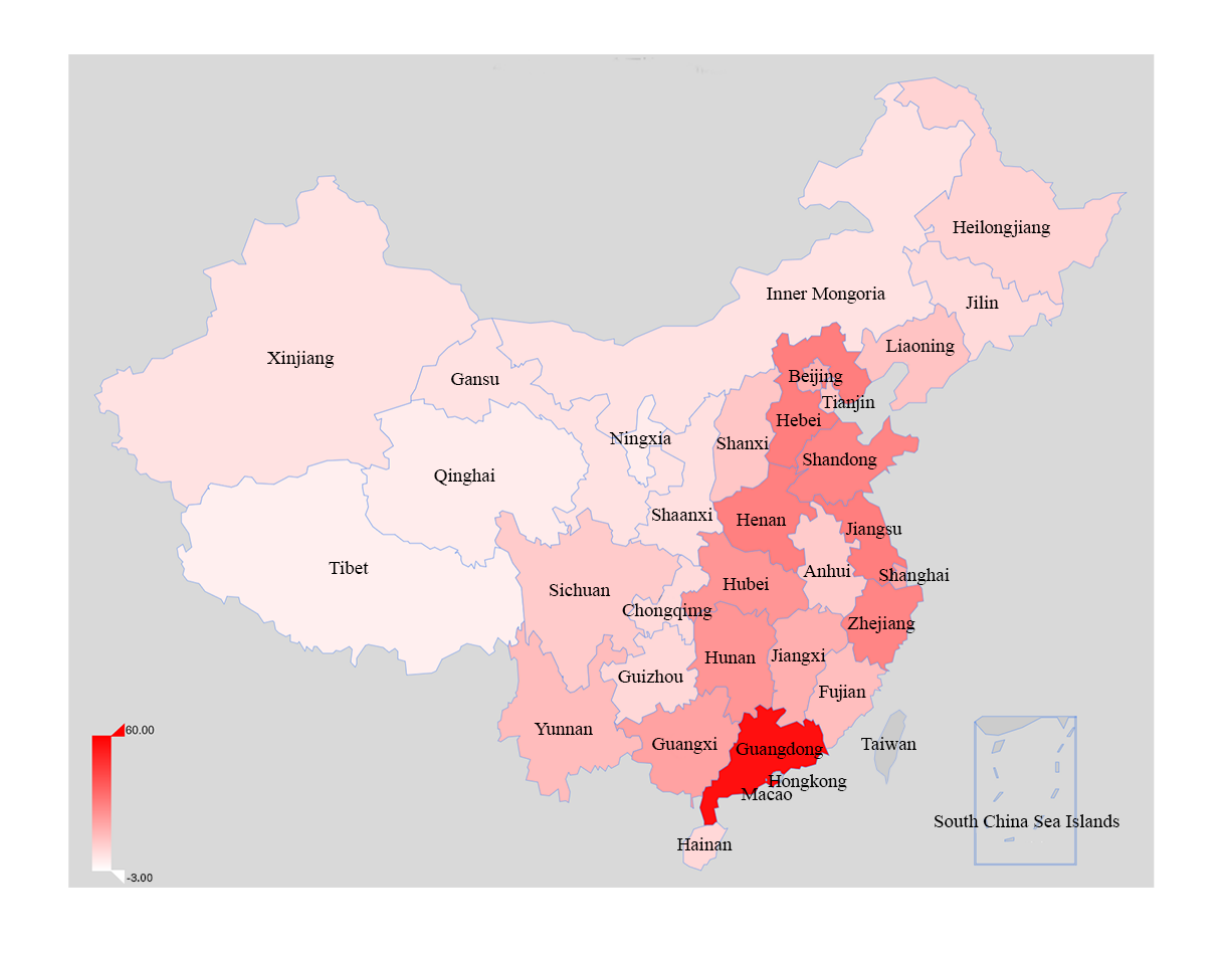
Figure 2. Distribution of 451 assisted reproduction technology center across Mainland China.